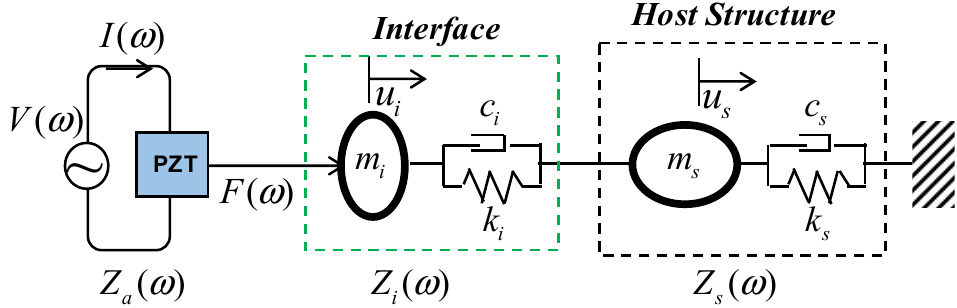
Figure 3. The 2-dof electromechanical impedance model of the PZT interface–host structure system.